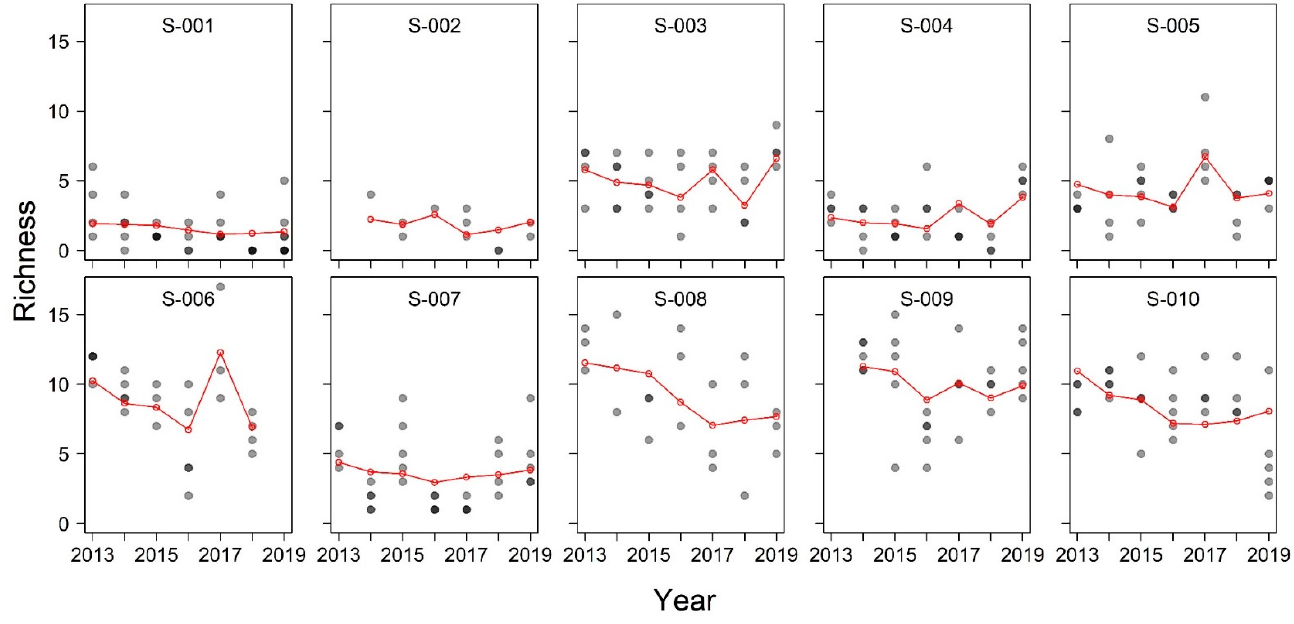
Figure 4. Observed fish species richness from seine hauls in association with habitat variables from the St. Clair and Detroit rivers aggregated across sampling sites and years.